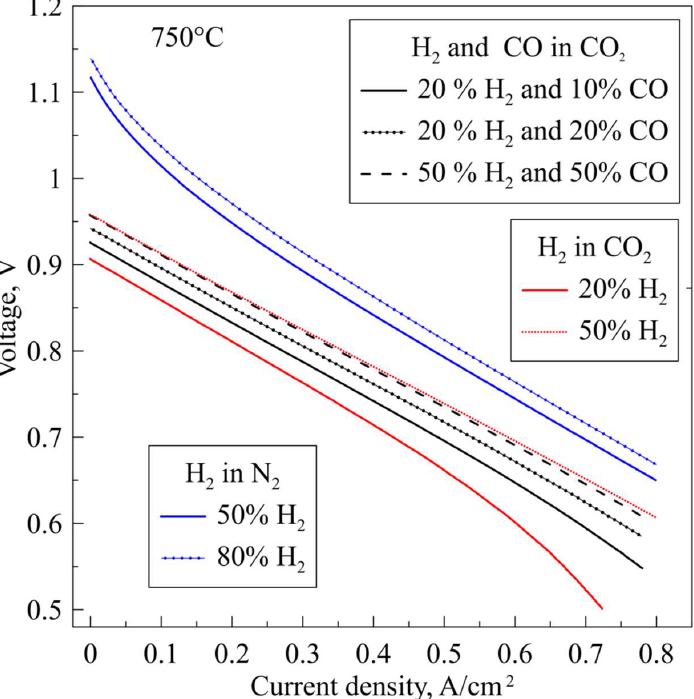
Figure 6. The role of fuel composition on SOFC performance. Total flow of 1000 Nml/min was applied for both fuel and air side.